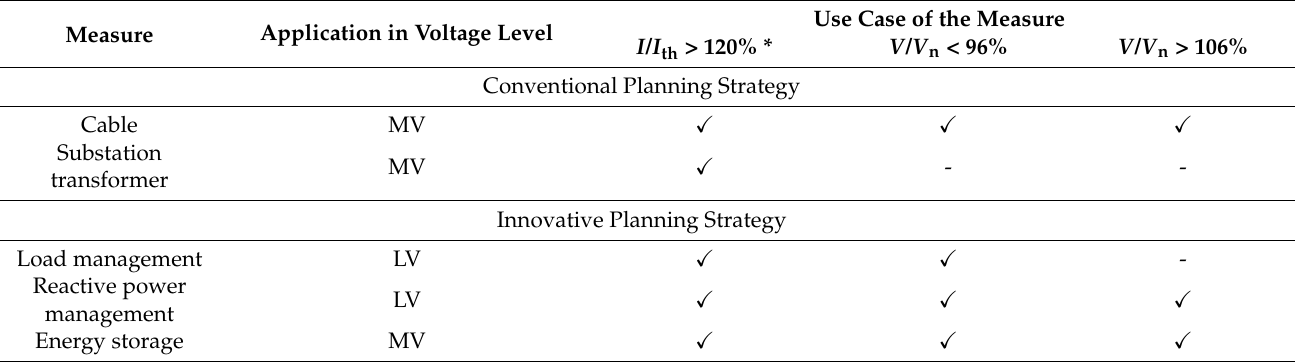
Table 2. Overview of the use cases for conventional and innovative planning